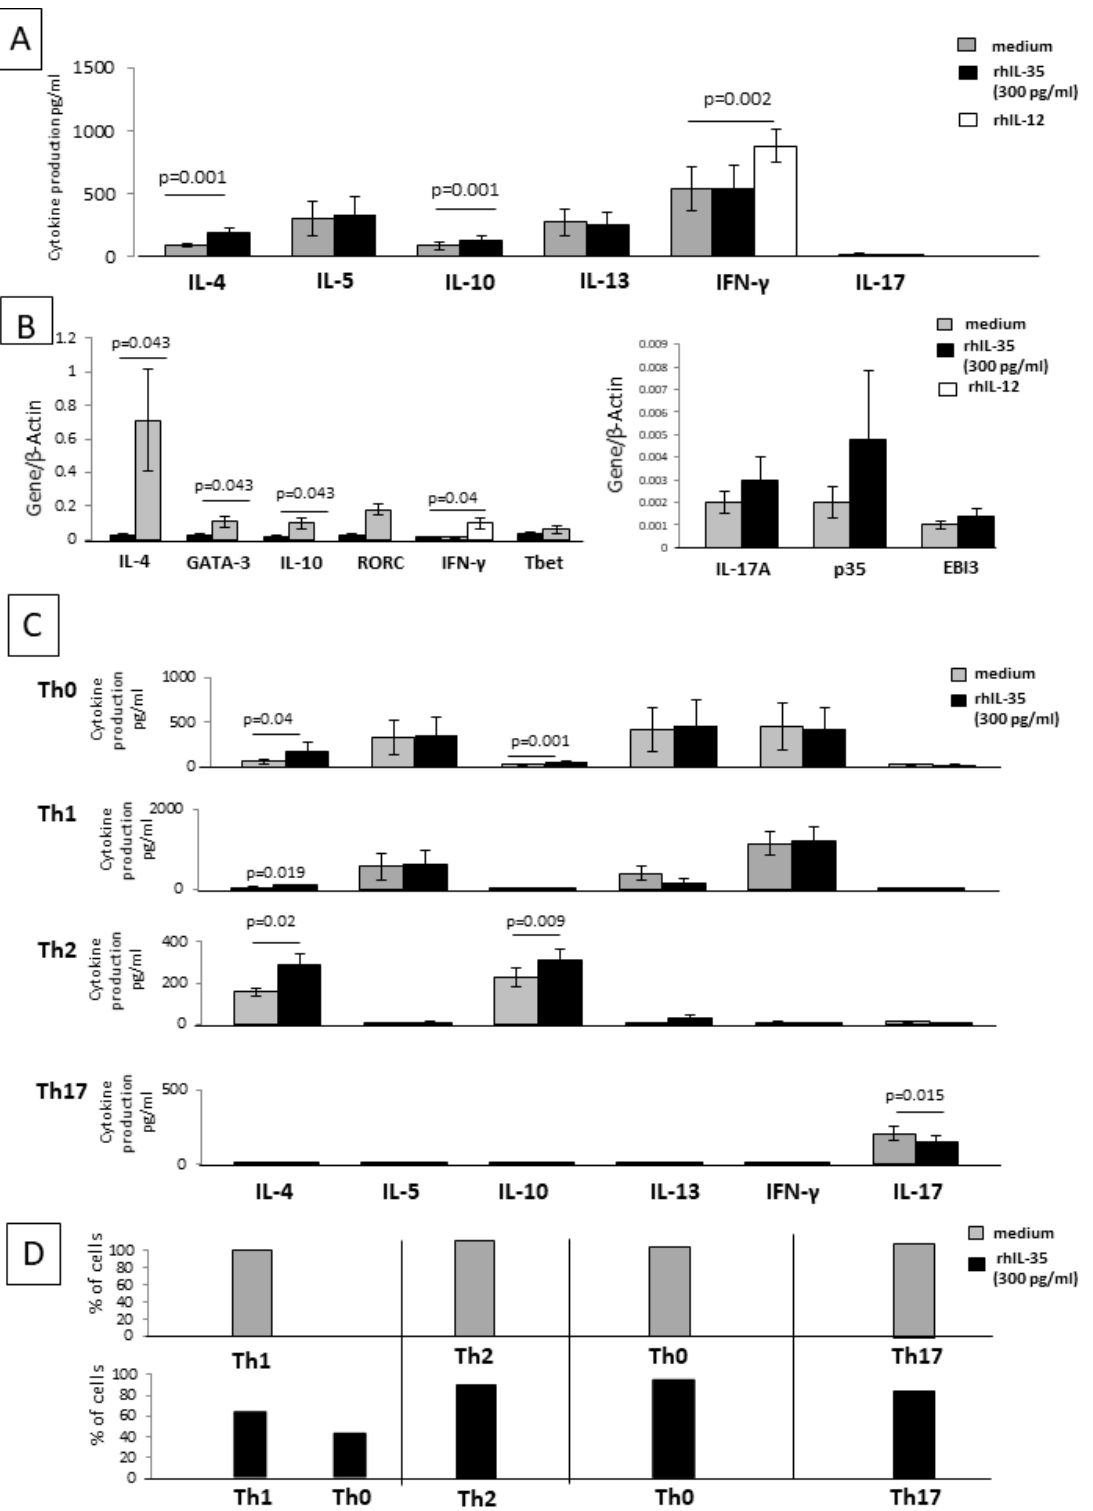
Figure 4. Direct effects of rh IL-35 on the cytokine profile of established CD4+ T-cell clones. ( A ) To provide evidence of the direct effect of rhIL-35 (300 pg/mL) on the cytokine production by T cells, IL-4, IL-5, IL-13, IL-17A, IFN- γ , and IL-10 production were measured with multiplex assays in the supernatant of 15 established T-cell clones stimulated by an immobilized anti-CD3 mAb. ( B )